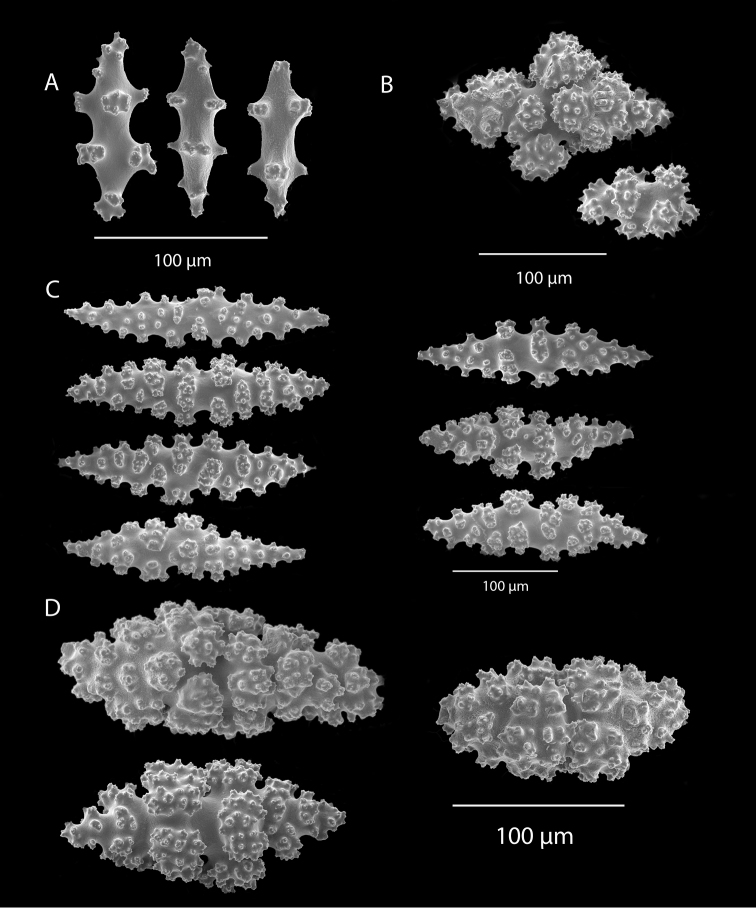
Leptogorgia sp. A, SBMNH 423080, SEM image. A Anthocodial sclerites B Coenencyhmal sclerites of odd shape C–D Coenenchymal spindles. Compare this SEM with SEM images shown in Breedy and Cortés (2011).